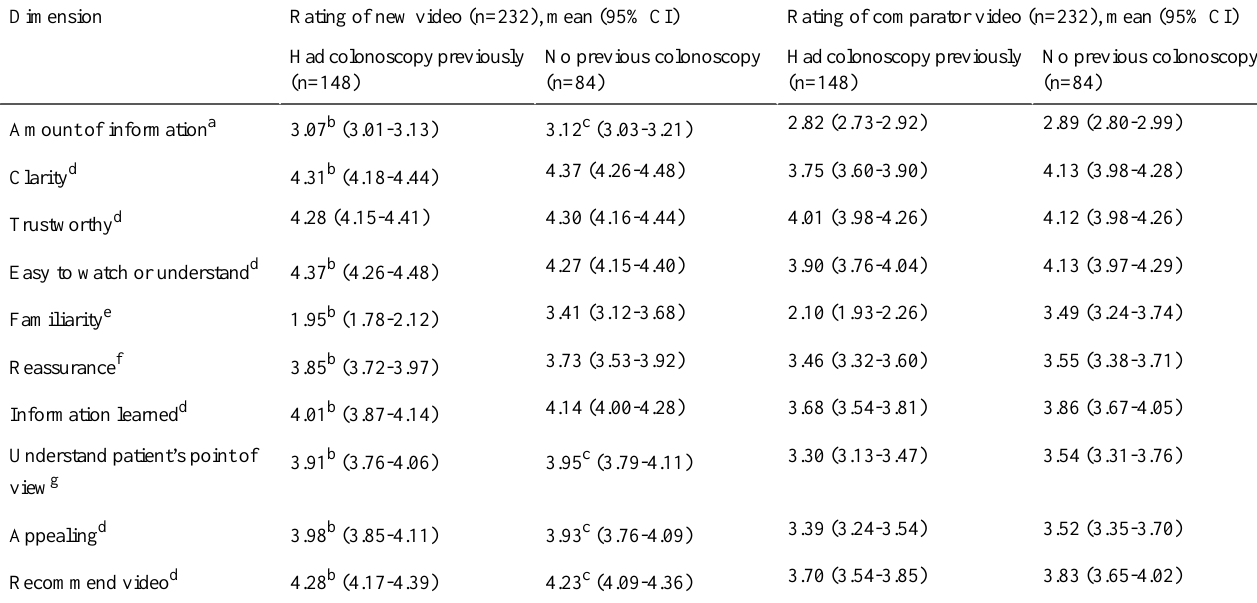
Table 5. Rating of the dimensions of the current and revised videos, stratified by previous colonoscopy